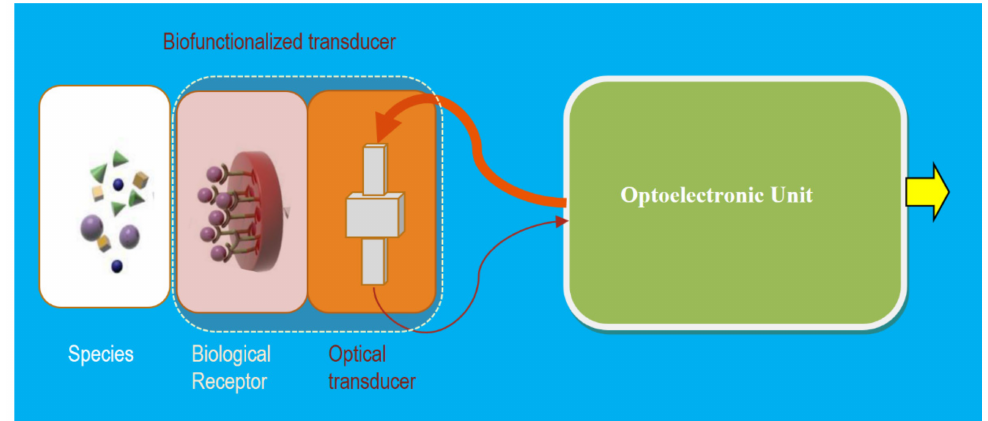
Figure 10. A general schematic illustration of a BioPhotonic Sensor: The bio-functionalized transducer is constituted by a specific biological receptor on the right part of an optical transducer; only the specific bio-species (Mx) will be placed on the particular receptor changing (modulating) the optical properties on the optical transducer response. These changes are detected and correlated with the Mx and, after the proper processing, the output is given by the optoelectronic unit. If some kind of specific intelligence is added, then an actuation signal could be offered at the OU’s output. The optical transducer can be implemented using different technologies, being more valuable than the integrated optics one. Courtesy of the